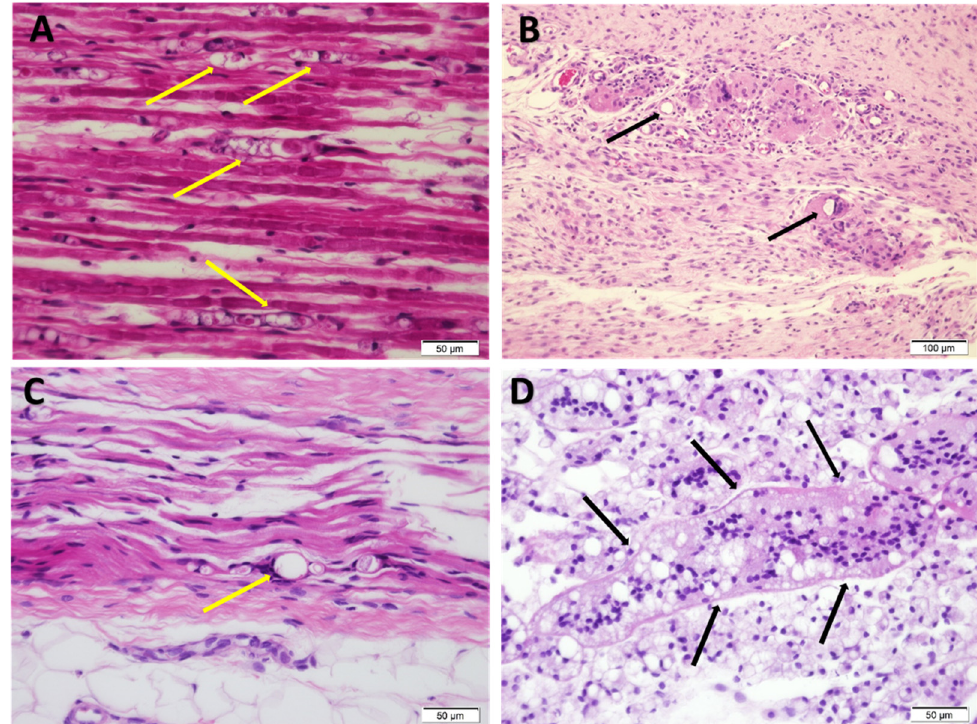
Figure 6. Sciatic nerve at the injected site 2 weeks after perineurial injection of lidocaine 4 mg 4% ( A ), Bupigel 5.32 mg ( B , C ) or Bupigel 7.5 mg ( D ). The yellow arrows indicate ovoids, consistent with Wallerian-like degeneration and the black arrows point to foreign body type granulomas (H&E staining, ×40 (A, C and D) or ×20 [B]).